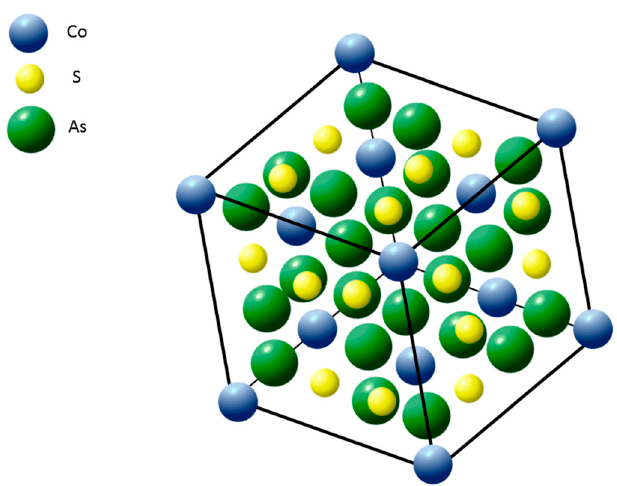
Figure 11. Model of the cobaltite multiple twin according to [73]. Projection along the [111] direction. In this cell, there are 52 atoms (4 Co, 24 S, and 24 As).